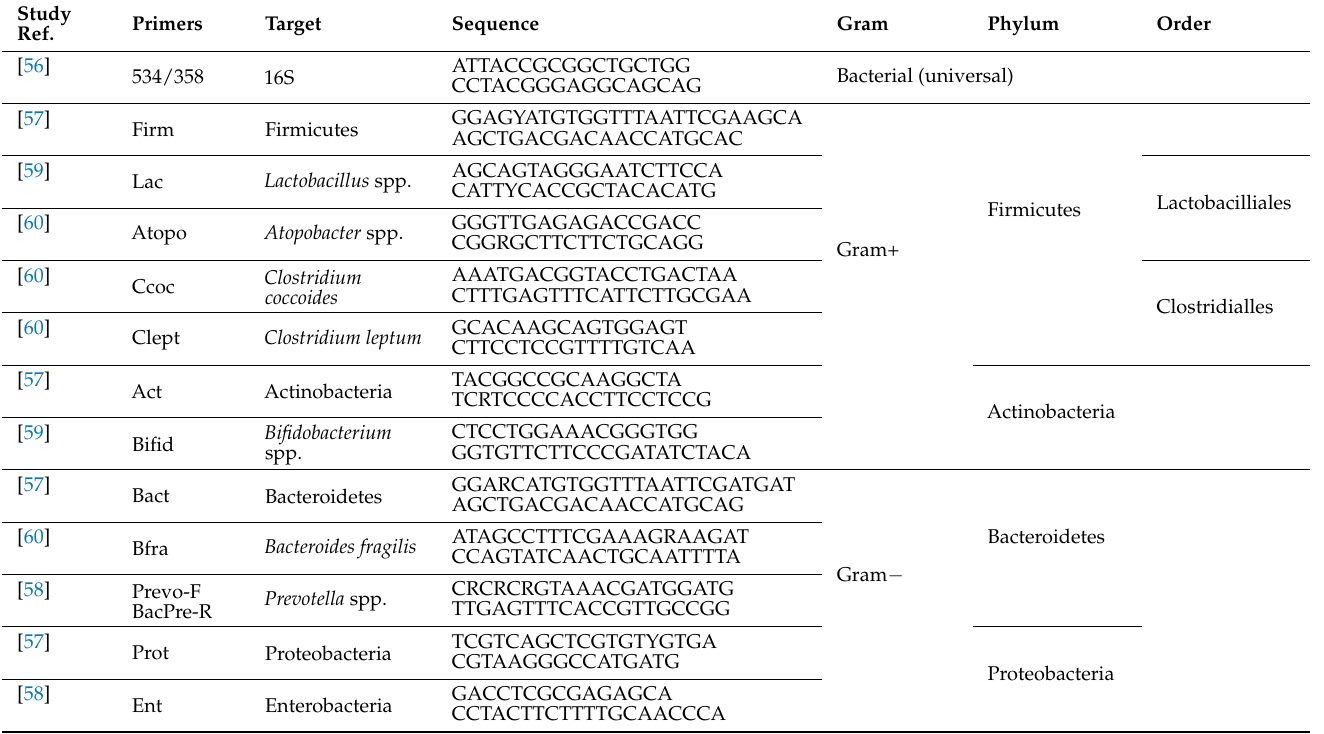
Table 4. List of primers used for microbiota phylogenetic